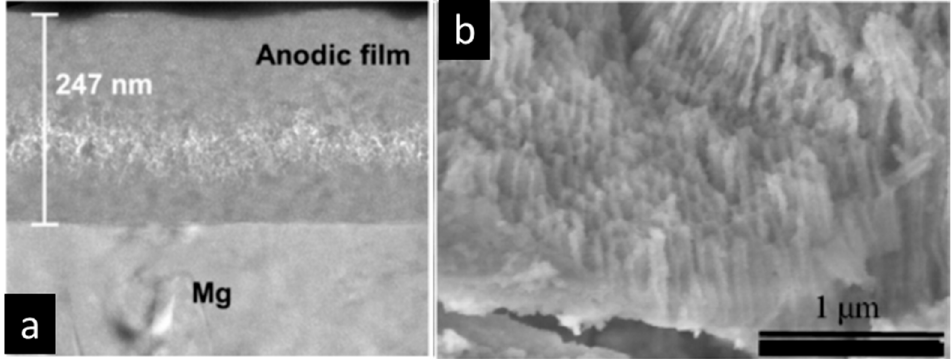
Figure 16. Oxide films formed on Mg alloys in organic electrolytes: ( a ) barrier type [261]; ( b ) nanotubular type [260]. Reprinted ( a ) from [261] and ( b ) from [260] with permission from Elsevier.